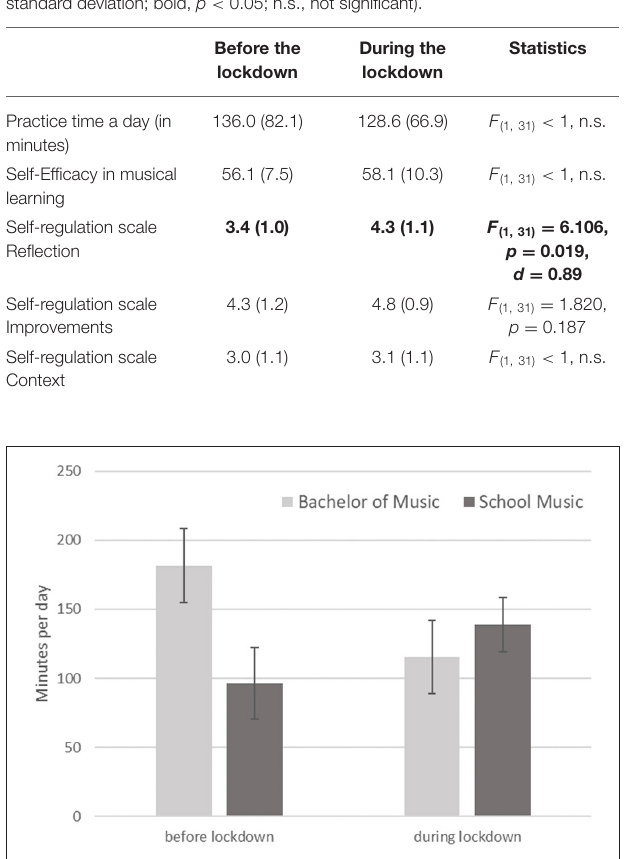
FIGURE 1 | Mean practice times per day at the two measuring times split by study profile (error bars: standard error of the mean).